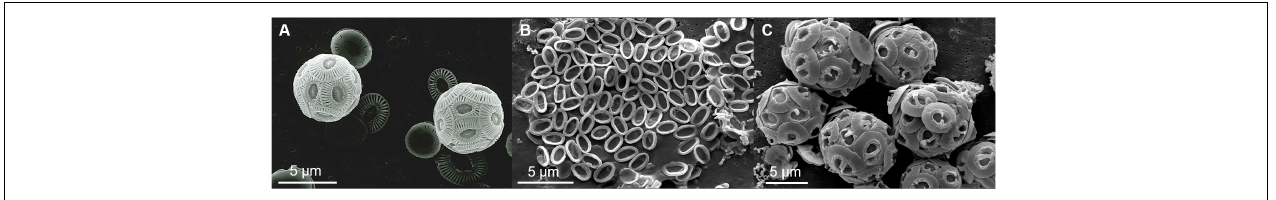
FIGURE 8 | Scanning electron micrographs of individual coccolithophore species from the respective strains used in the experiments (see methods). (A) Coccospheres of E. huxleyi . (B) collapsed coccosphere of P. carterae . (C) Coccospheres of G. oceanica . The pictures (B,C) were kindly provided by Dr. Giulia Faucher and were published previously in a study that compared physiological and morphological characters of four coccolithophore species under different abiotic conditions (Faucher et al.,